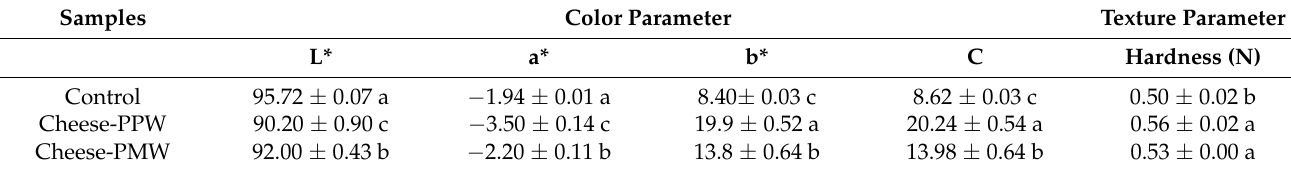
Table 6. Color and texture of cheese samples enriched with pomegranate extracts.